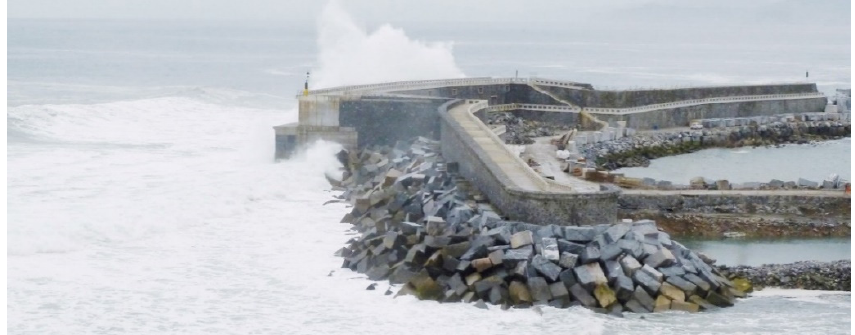
Figure 12. OWC plant installed in the bay of Mutriku (Spain) [54].